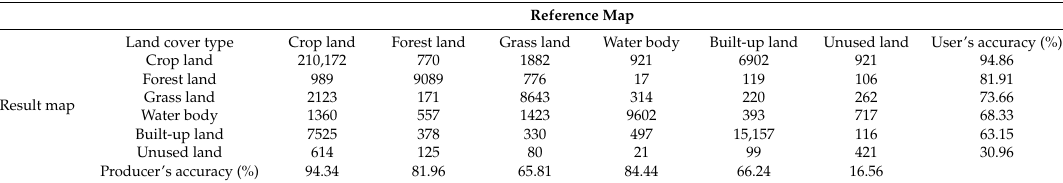
Table 5. Confusion matrix between the improved rotation forest result and the reference data after EVI